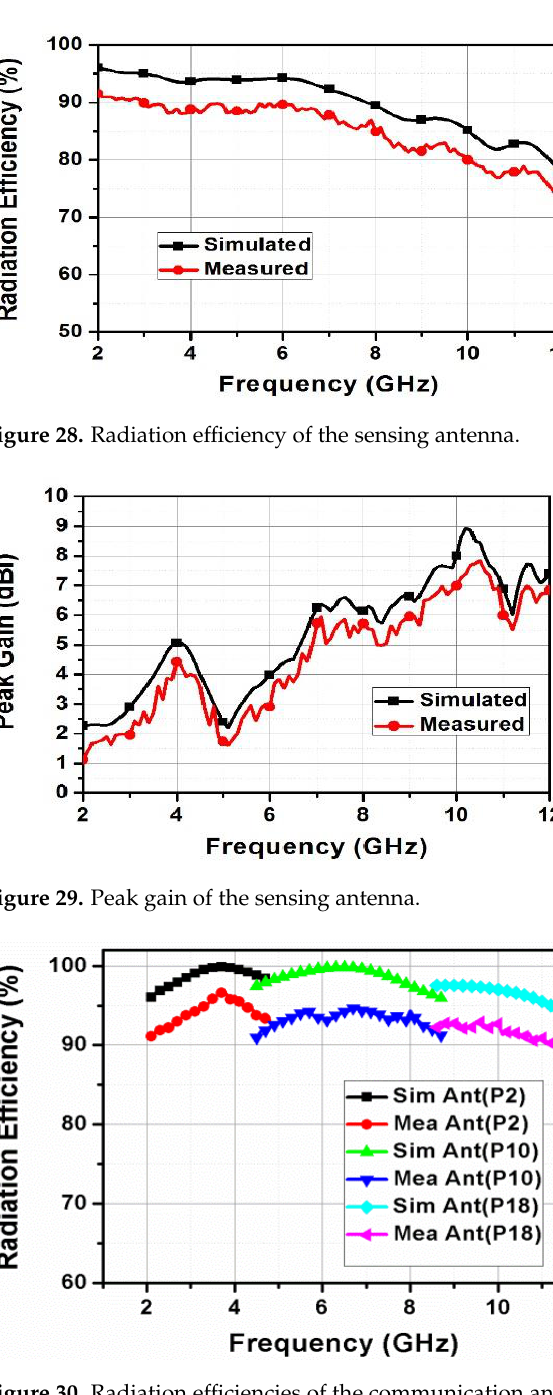
Figure 30. Radiation efficiencies of the communication antennas .